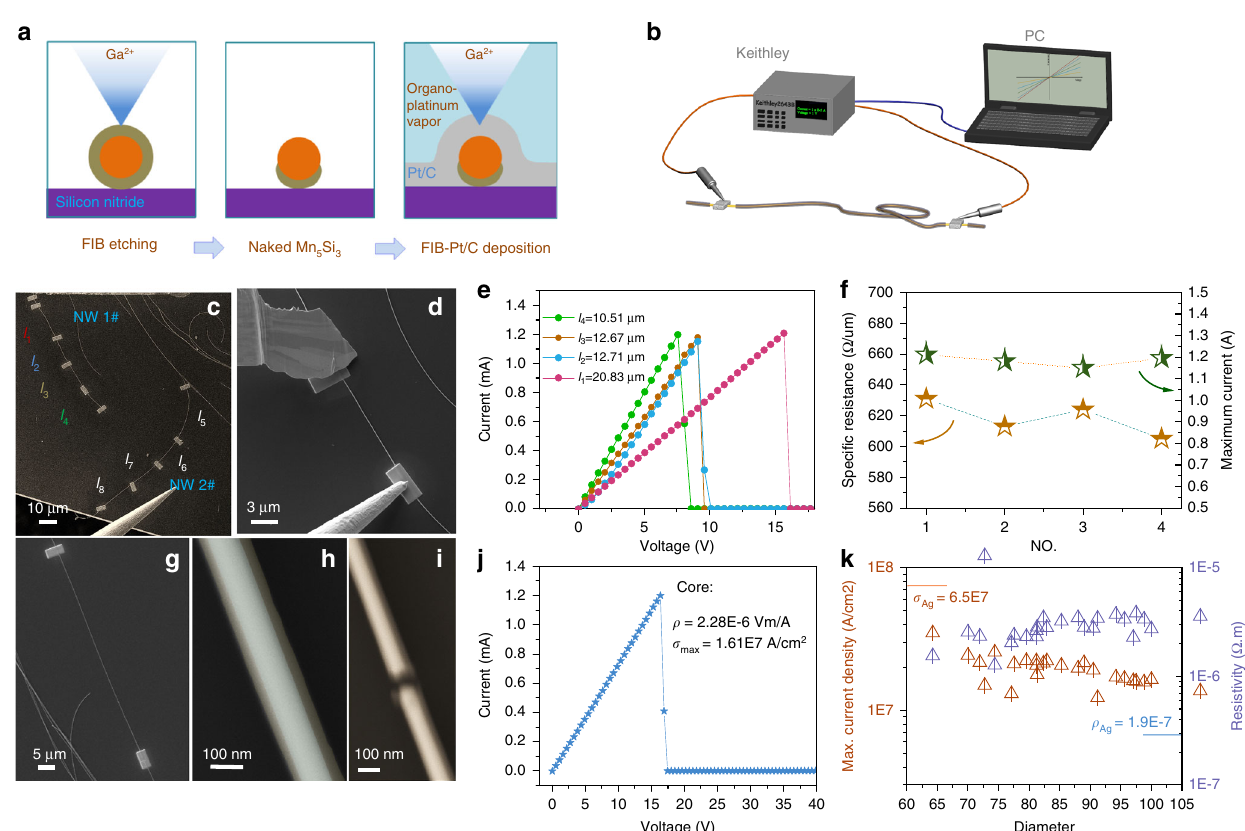
Fig. 3 The basic electrical performance investigation of Mn 5 Si 3 @SiO 2 nanocables. a the schematic of double-electrodes device with FIB. b The I – V measuring circuit employed in SEM chamber. c Two nanocables made into several independent electron channels with various lengths. d The testing con fi guration under SEM observation. e Acquired I – V curves of device l 1 – l 4 . f The speci fi c resistances and maximum currents corresponding to l 1 – l 4. g A typical device used to determine the resistivity and current density. h high magni fi cation SEM image with false color to determine the core thickness. i The breaking down point after testing. j The I – V curve recorded, which determine a resistivity of 2.28 × 10 − 6 Ω m and maximum current density of 1.61 × 10 7 A cm − 2 . k The values corresponding to 25 nanocables with various